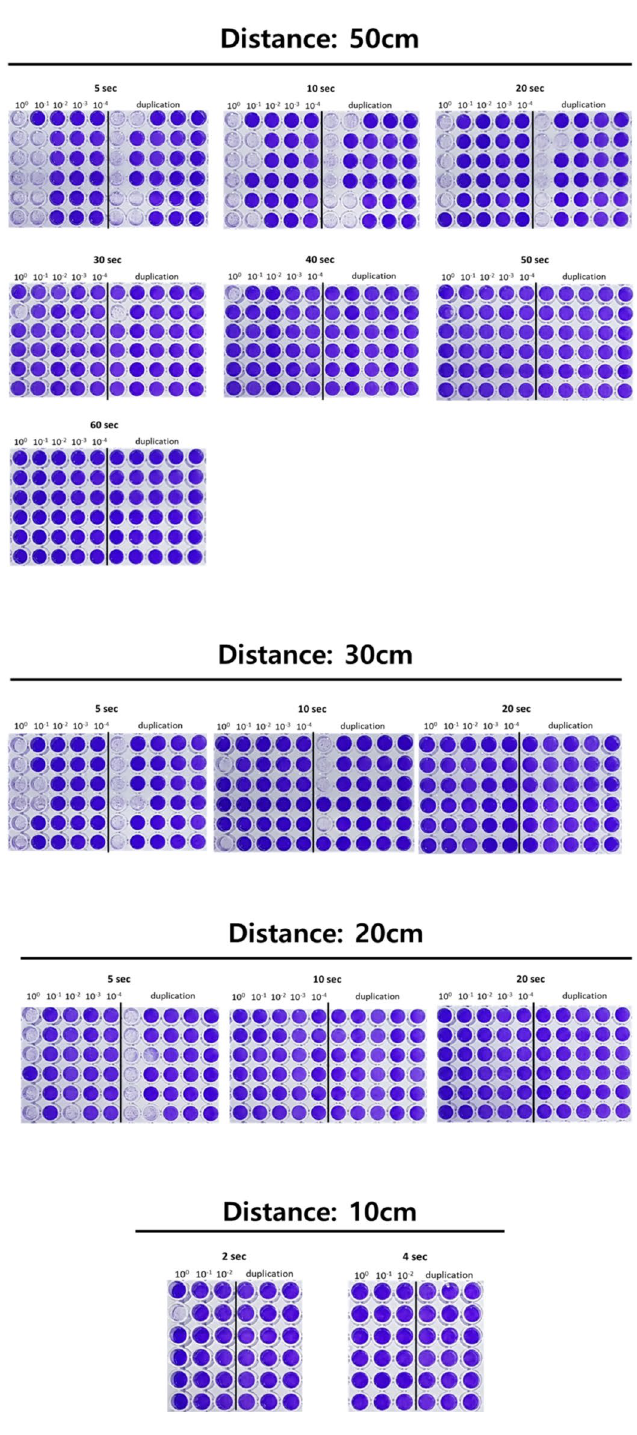
Figure 3. Crystal violet staining of Vero E6 cells infected with UV-irradiated SARS-CoV-2. Vero E6 cells were infected with UV-irradiated virus and incubated for 3 days. Cells were then stained with a crystal violet